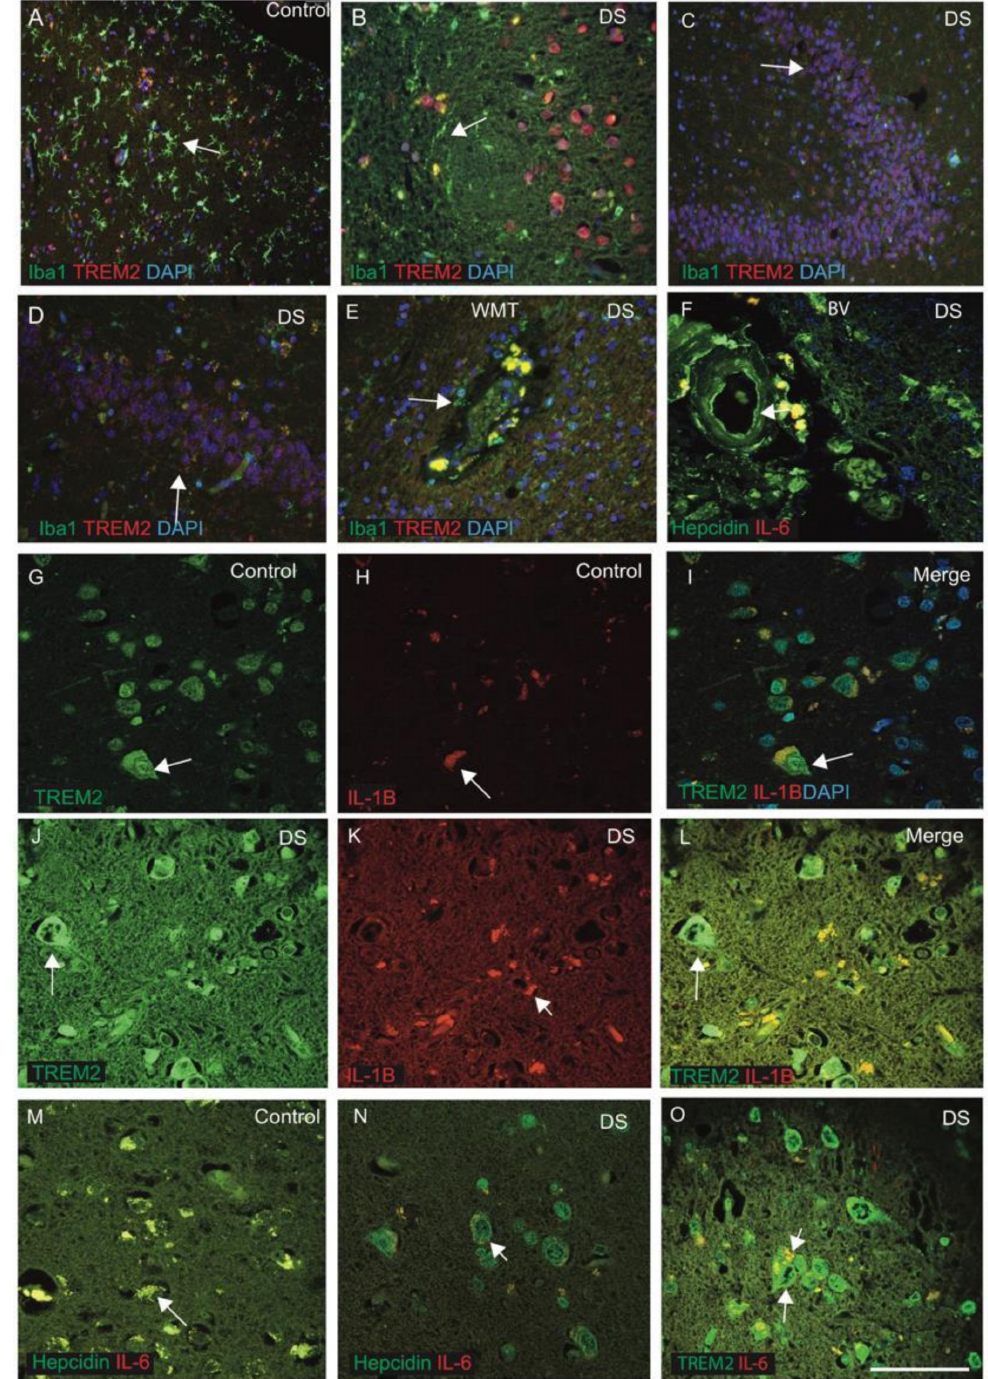
Figure 5. Inflammatory changes in the DS brain were identified by TREM2, IL-1 β and IL-6. To investigate the inflam- matory changes in DS, the brain sections from DS and control subjects were stained with microglia marker (Iba1) and TREM2. In control brains, Iba1-positive ramified microglia were visible in the cortex, whereas TREM2 was noticed in the neurons close to the blood vessels ( A ). In the DS brain sections, activated microglia was visible around the SP and limited co-localisation with TREM2 in the microglia ( B ). For sections from the HP and DG of DS brain when stained with Iba1 and TREM2, Iba1-positive activated microglia were present close to the neurons, whereas TREM2 expression was visible only in the damaged DG granule cells with limited co-localisation ( C , D ). The white matter (WM) close to the blood vessels (BV) in the DS brain showed large numbers of Iba1-positive microglia, close to the blood vessels, that might be involved in the clearing process of damaged oligodendrocytes, and TREM2-positive macrophages might be entering from blood vessels ( E